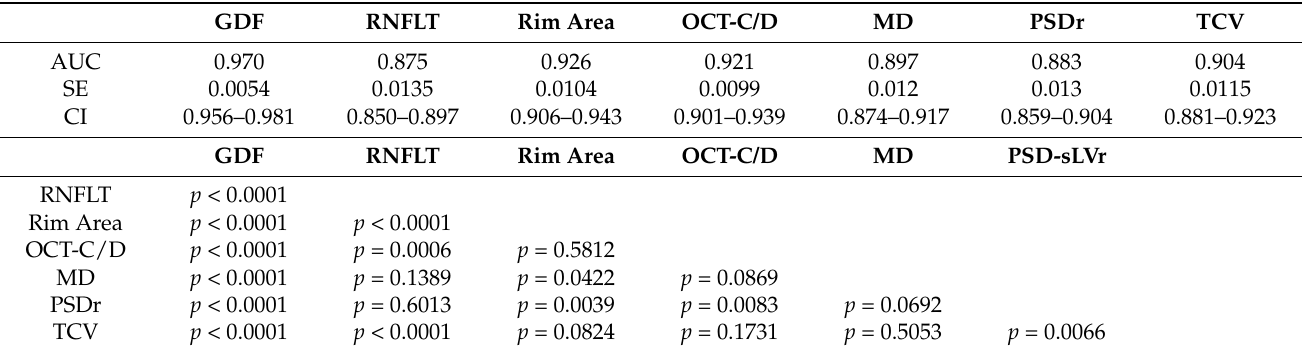
Table 1. Performance of Laguna OnhE, OCT, and perimetry indices.